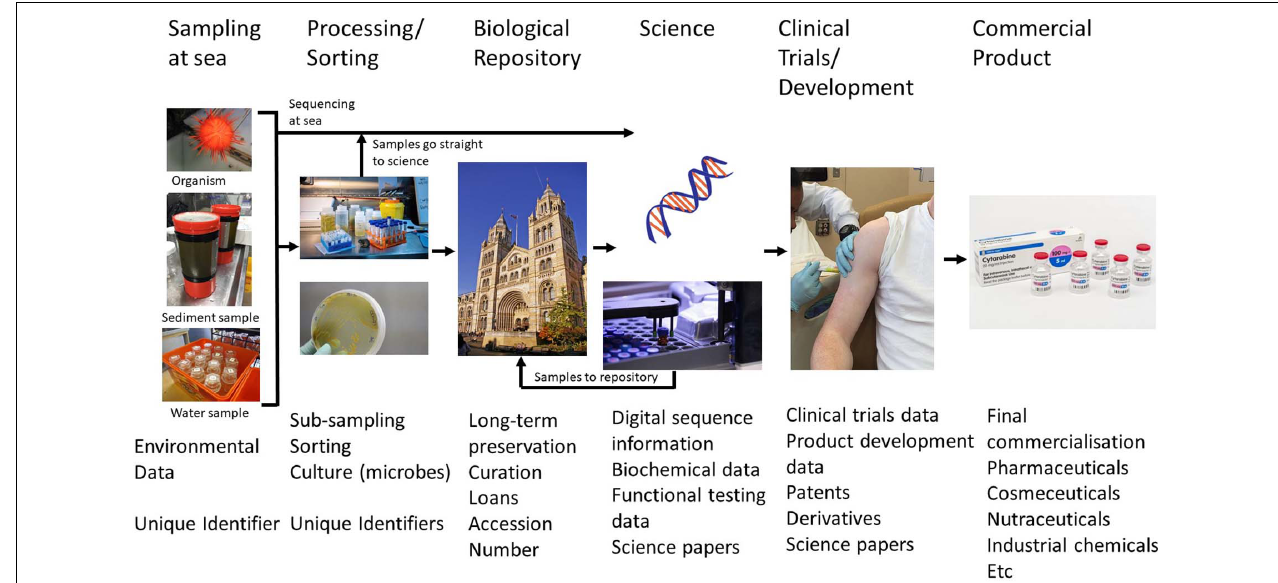
FIGURE 4 | Schematic diagram showing the processes of marine scientific/MGR research from sampling, sample processing, laboratory investigation through to commercial product. Stages where unique identifiers are assigned and data produced are shown. Images are from the following sources: A. D. Rogers; M. L. Taylor; M Jaspers; Christine Matthews (Geograph Project); NIAID (Wikipedia Creative Commons); Pfizer, Netherlands